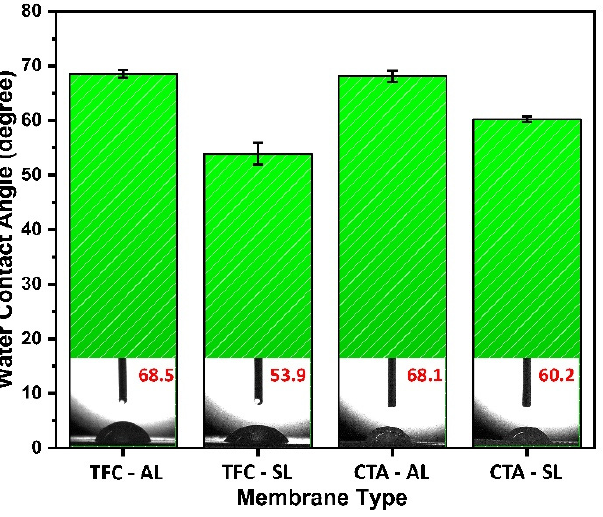
Figure 2. Water contact angle for virgin Porifera TFC and FTSH2O™ CTA membranes.